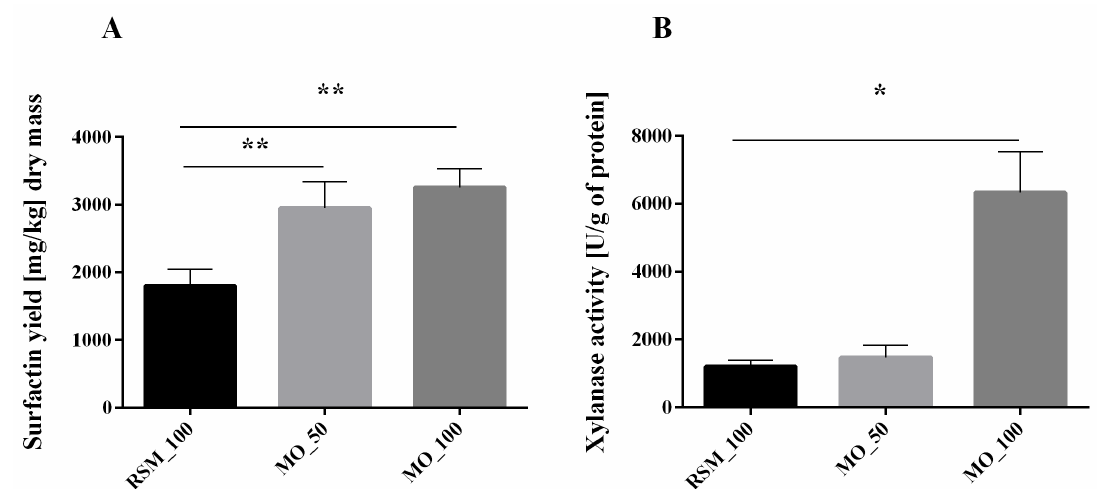
Figure 1. Surfactin yield ( A ) and general xylanase activity ( B ) obtained during 24 h solid-state fermentation (SSF) using B. subtilis 87Y. RSM—rapeseed meal, MO—milled oats followed by a number specifies the level of RSM replacement by MO. Statistical significance in all cases is presented as follows: * p < 0.05; ** p < 0.01.